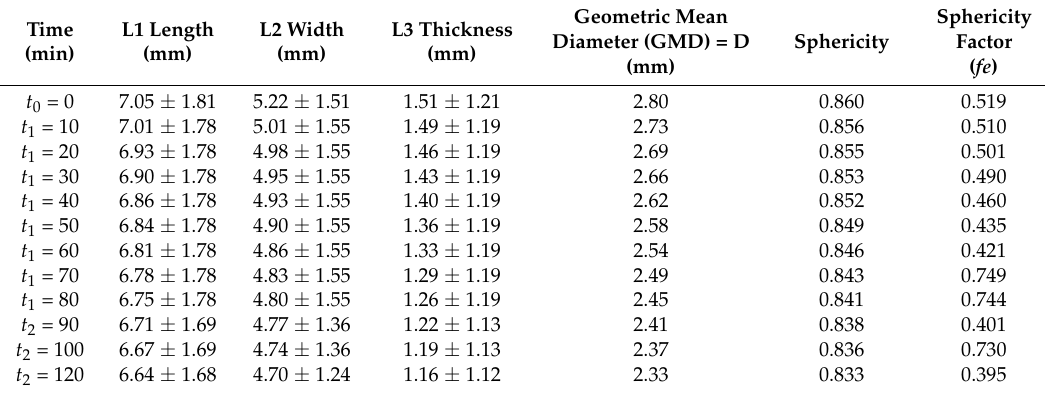
Table 1. Physical characteristics of the components of the stevia solid